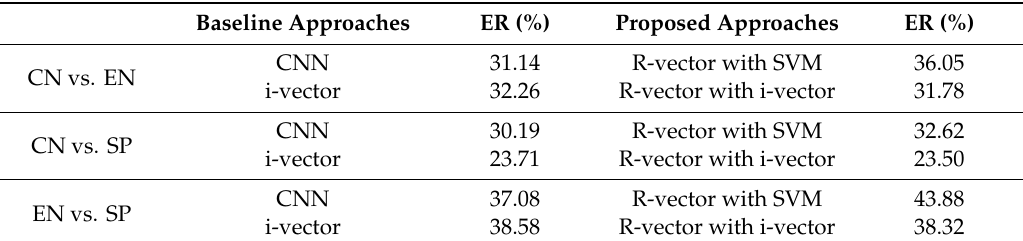
Table 6. Performance (Error Rate (ER)) of two-class LID experiments on Mozilla corpus. CN: Chinese, EN: English, SP: Spanish.